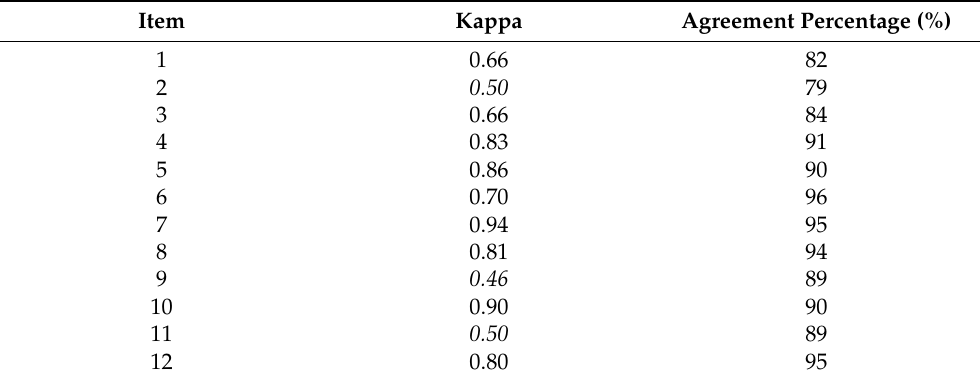
Table 4. Child–relative reliability of the Portuguese version of MISS.